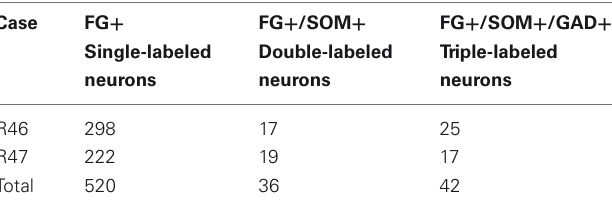
Table 3 | Cell counts of labeled neurons in the posterior subdivision of the basomedial amygdalar nucleus in sections labeled for FG, SOM, and